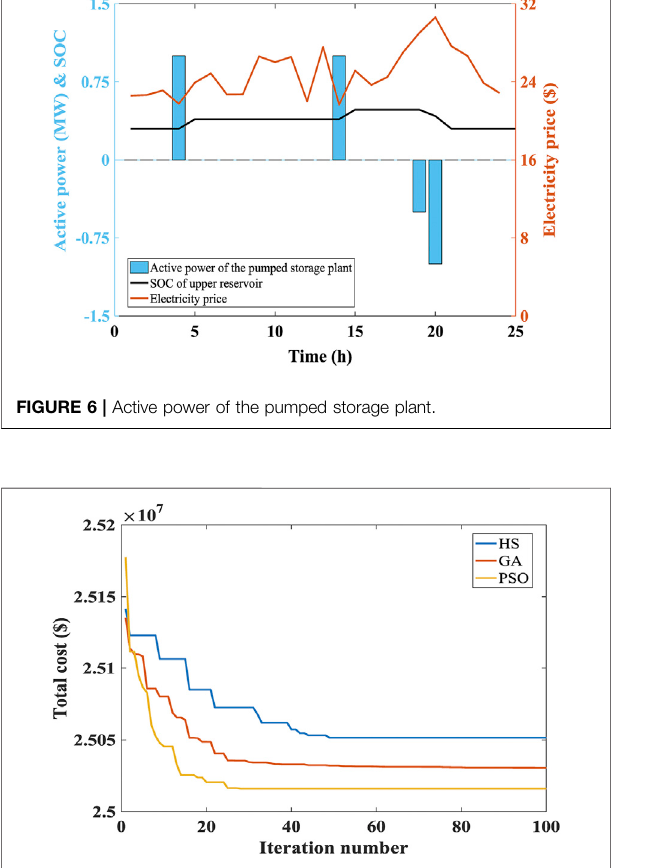
FIGURE 7 | Convergence